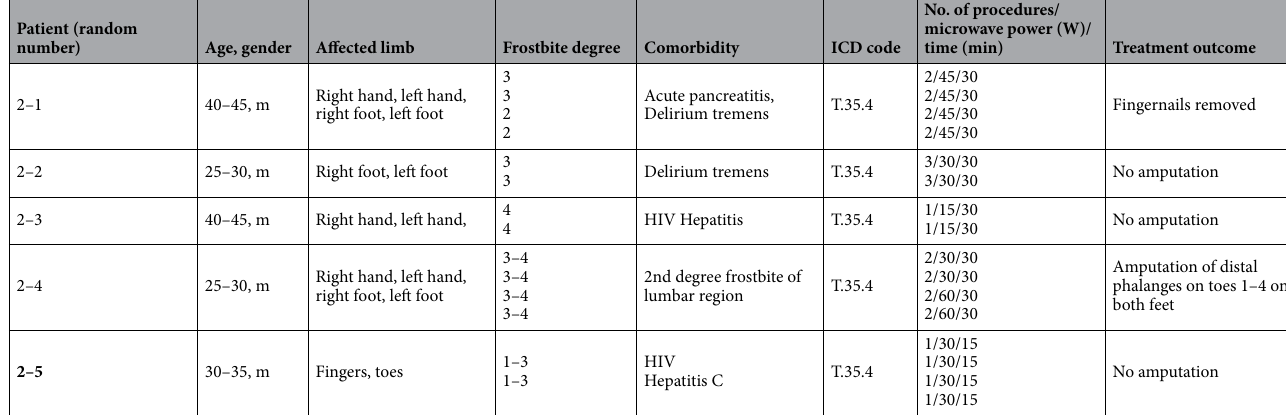
Table 1. The outcomes of treatment of cold-induced limb injuries with microwave rewarming in MSU No.